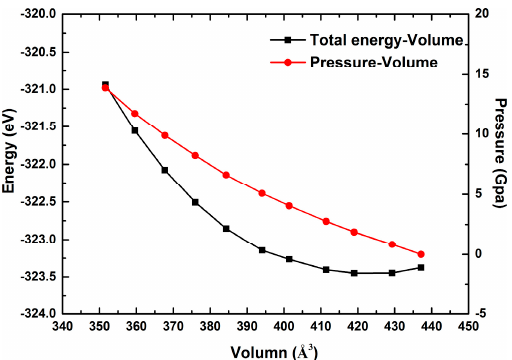
Figure 2. The relationship between total energy-volume ( E - V ) and pressure-volume ( P - V ) of pyrophyllite [Al 4 Si 8 O 20 (OH) 4 ]. The black solid square was the first round of calculation E , and then P could be derived from the relation P = −Δ E / Δ V . Table 2. Compared with experimental values, the calculated average bond lengths in optimized structure of pyrophyllite [Al 4 Si 8 O 20 (OH) 4 ] at 0 GPa and that of given pressures. Exp. [39] Pressure (GPa)